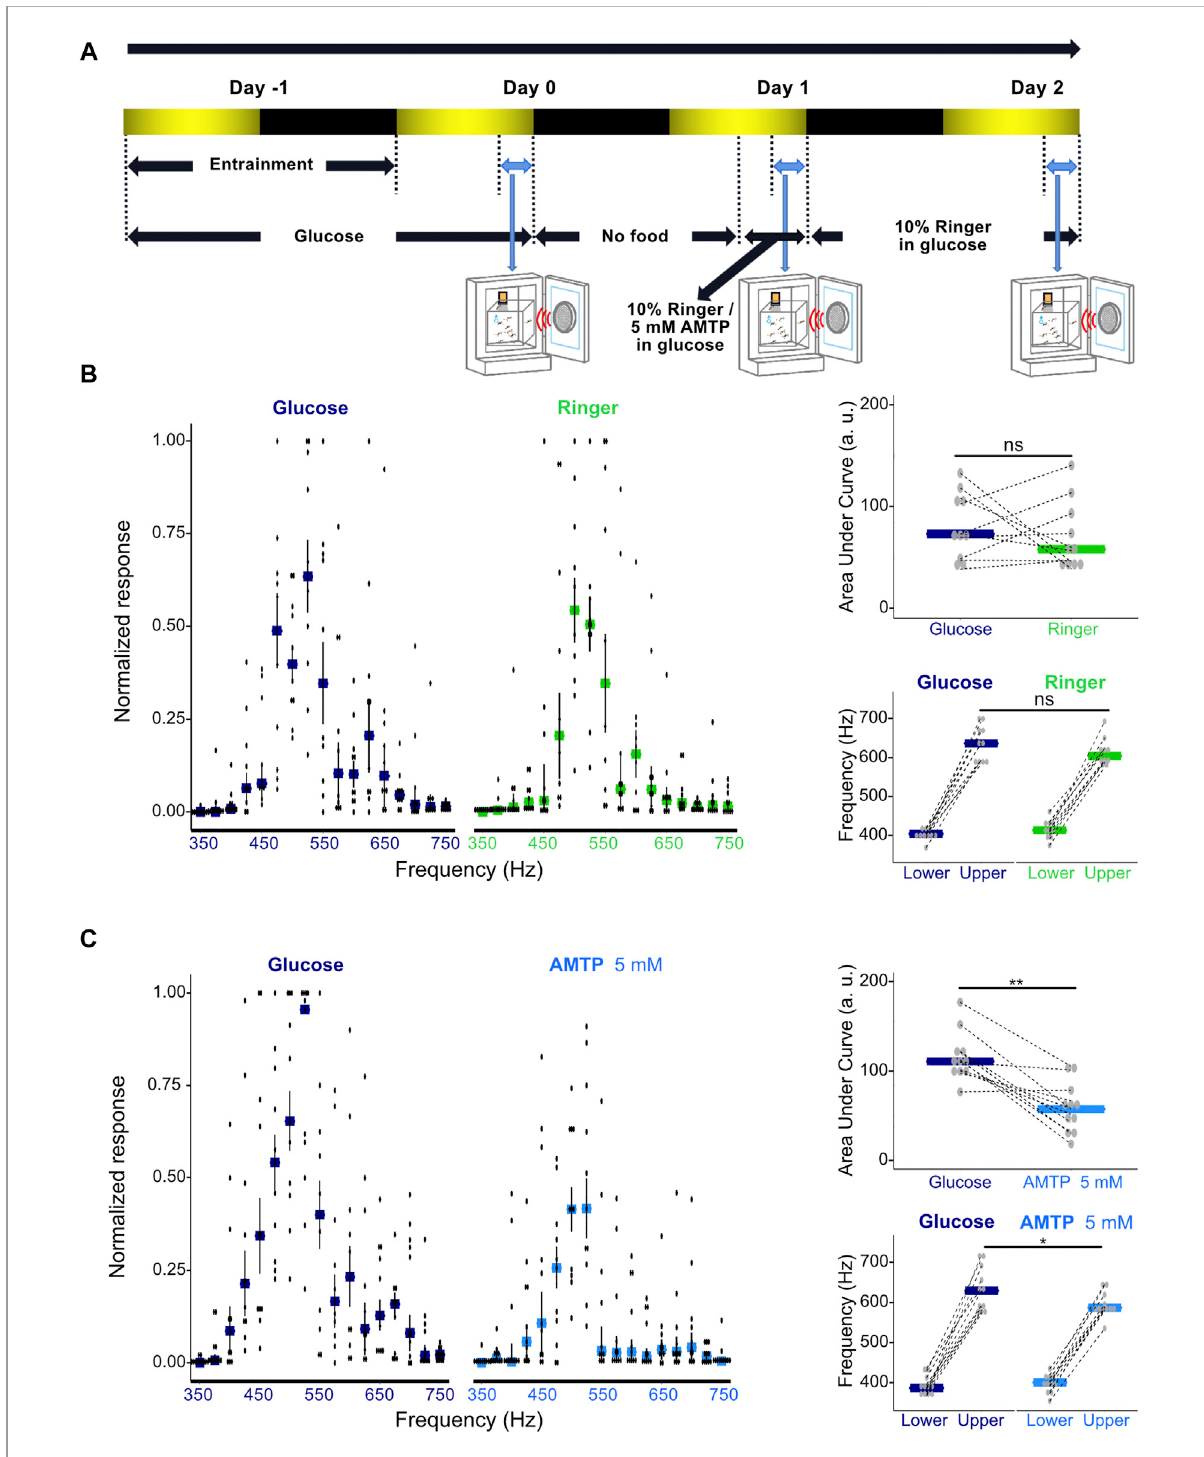
FIGURE 4 Modulation of serotonin synthesis signi fi cantly alters male phonotactic behavior. (A) Diagram of phonotaxis testing paradigm. Phonotactic behaviorwastestedatdusk(ZT12,indicatedbybluebidirectionalarrows).BaselinephonotacticbehaviorwasrecordedatDay0asaglucose-treated group. Phonotactic behavior after compound feeding was recorded at Day 1 as a Ringer or alpha-methyltryptophan (AMTP)-treated group. (B) Normalized phonotactic responses (left) for glucose (left, measured at Day 0) and Ringer (right, measured at Day 1) fed male mosquitoes. Bars represent median values for each frequency, error bars represent SEM, and dots represent values from individual repeats. Changes in the area under the curve (AUC) of male phonotactic pro fi le (top right) (AUC) between glucose (Day 0) and Ringer (Day 1) exposures. No signi fi cant differences